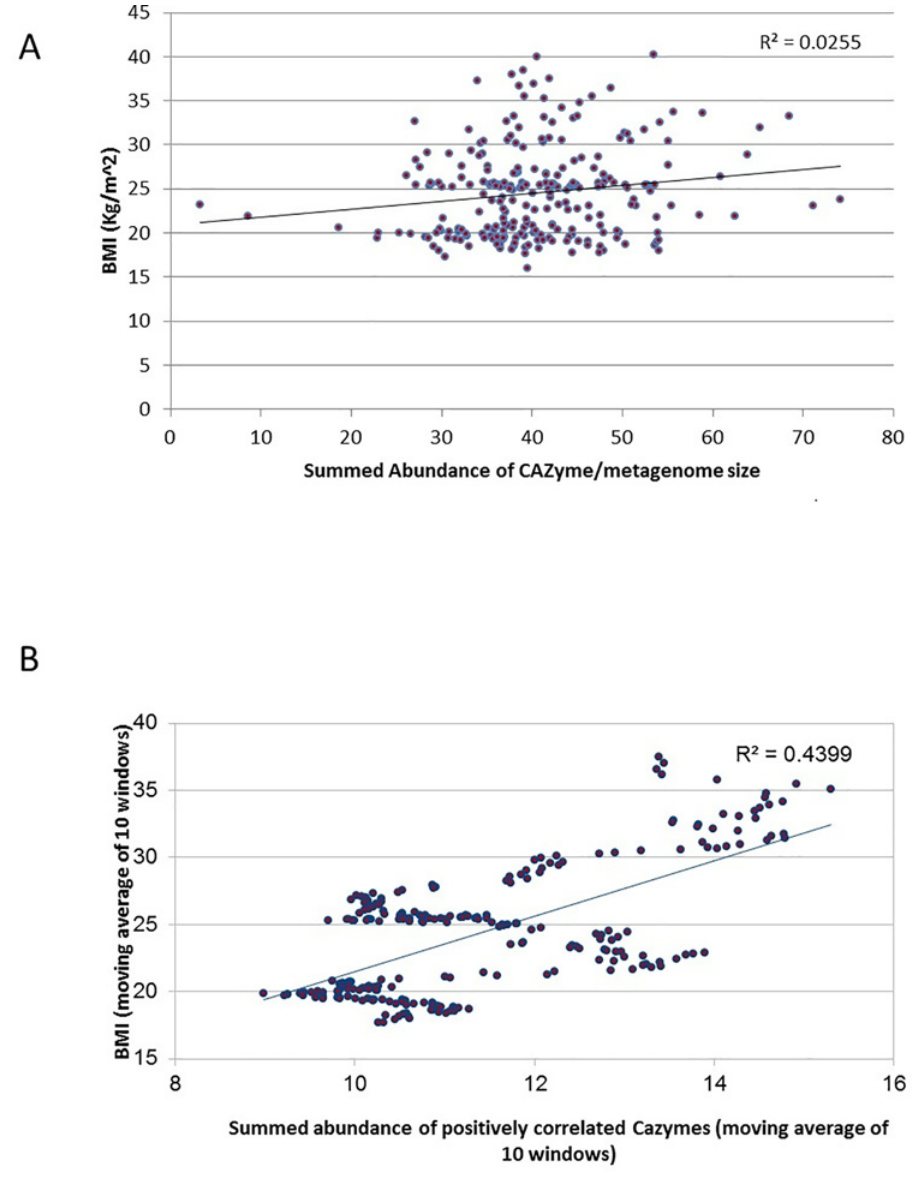
showing significant positive correlation with BMI. The overall summed abundance of all gut associated CAZyme families does not show any correlation with the BMI of the individuals. However, obtaining the correlation of the individual CAZyme families identified 10 such families (listed in Table 1) having a significantly positive correlation with BMI. The correlation of the summed abundances of these 10 families (computed using a sliding window based approach explained in the Methods section) with the BMI was observed to be even more significant (R^2 = 0.44, P <